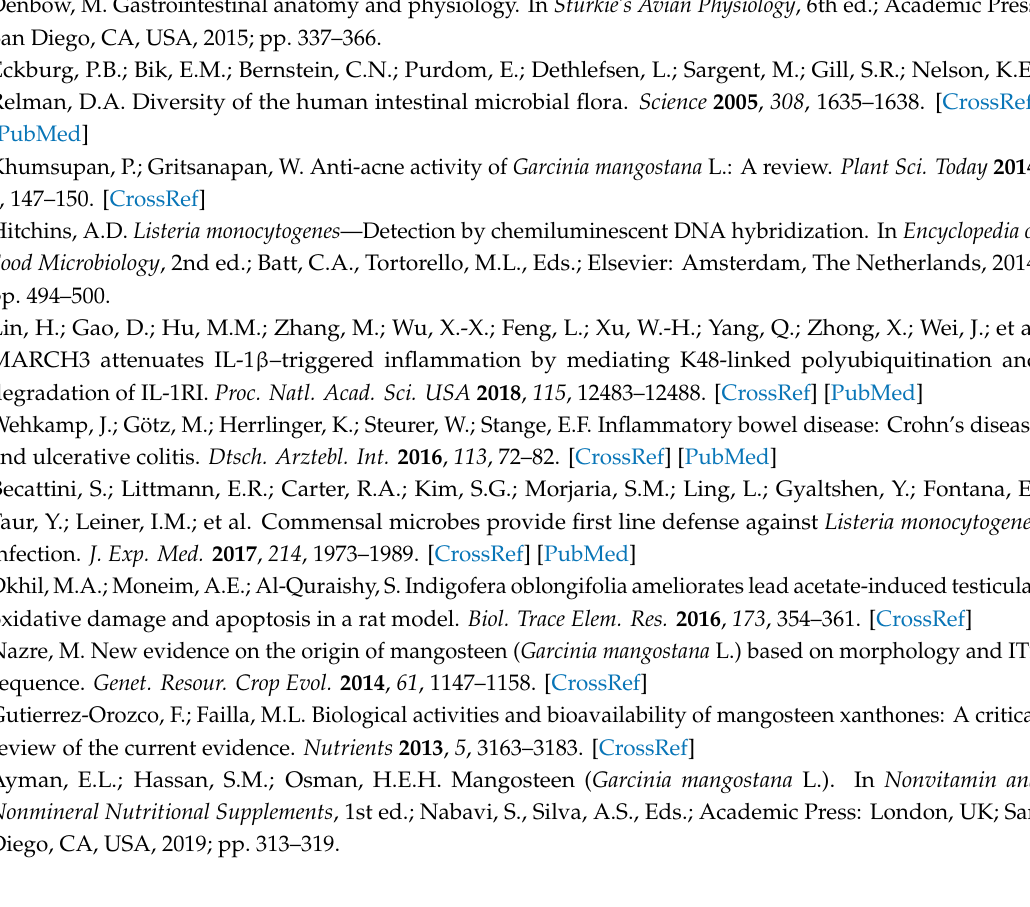
Table S1: content of total phenols, flavonoids, and antioxidant activity of flavonoids free-radical scavenging (DPPH and ABTS) and ferric reducing antioxidant power (FRAP) in methanol-extracted air- and freeze-dried mangosteen peel nanoparticles, Figure S1: total viable count of Listeria monocytogenes ATCC 19114 against optical density at 620 nm, Figure S2: optical density of Listeria monocytogenes ATCC 19114 at 620 nm at di ff erent time per